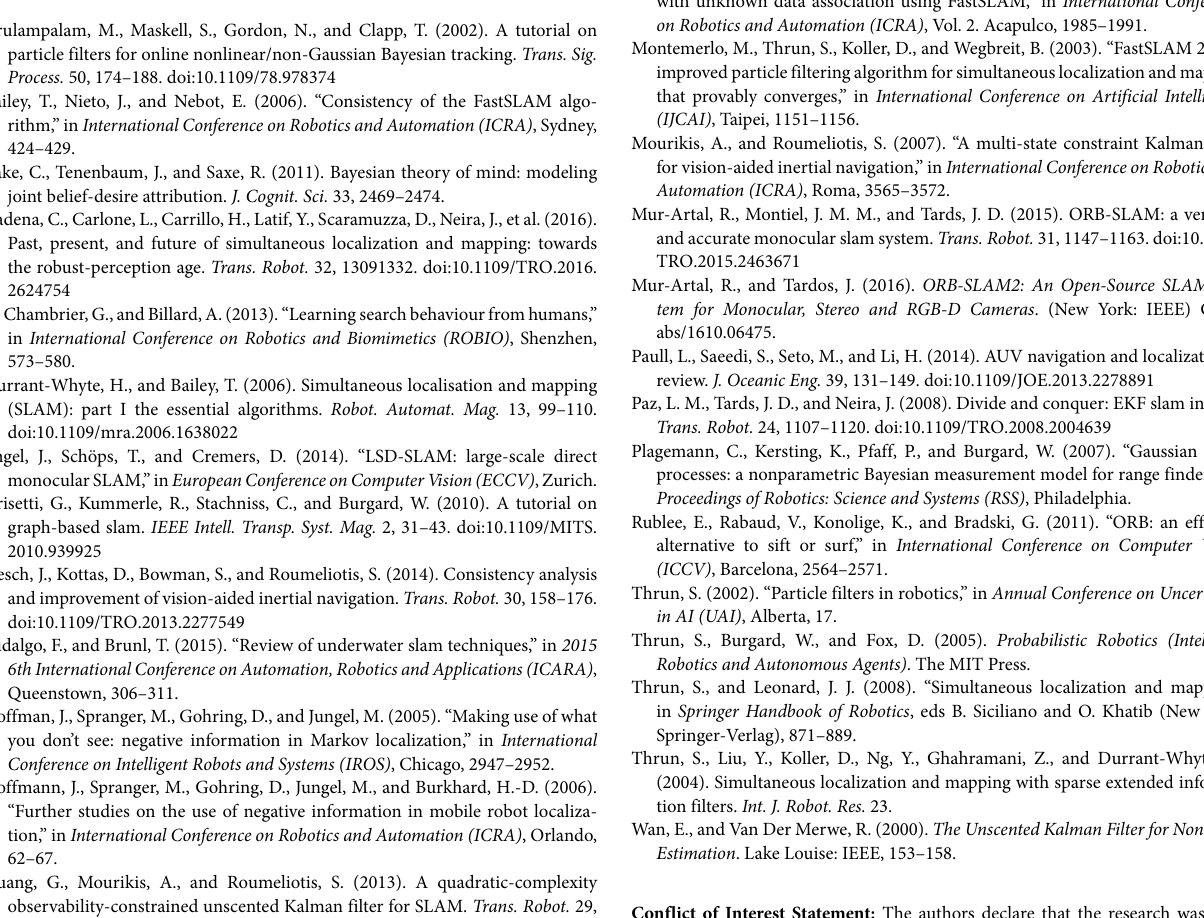
object being searched. Bottom right: product of the original marginals (dashed blue andredintopleftfigure)andthecurrentlikelihoodfunction.Bottomleft:thememory likelihood functions (equation (15)) which is the product of all likelihood functions. Top right: the joint distribution, which is result of the product of both functions in the bottom figures. The marginalization of the joint distribution would result in solid blue and red marginals, depicted in the top left figure. The marginalization is computed at each step along the pink line illustrated in the bottom right figure. This avoids performing an expensive margnisalization over the entire joint distribution. VIDEO S2 | 2D search example of an experiment illustrated in Figure 13 . The agent has to locate the red square. As the agent reduces his uncertainty by using the wall, this propegates to the entire object marginal (shown in red). VIDEO S3 | 2D search example of an experiment illustrated in Figure 13 . The agent must locate two objects (red and green). When the agent locates the red object, their marginals become the same, as both of them have to be located at the same